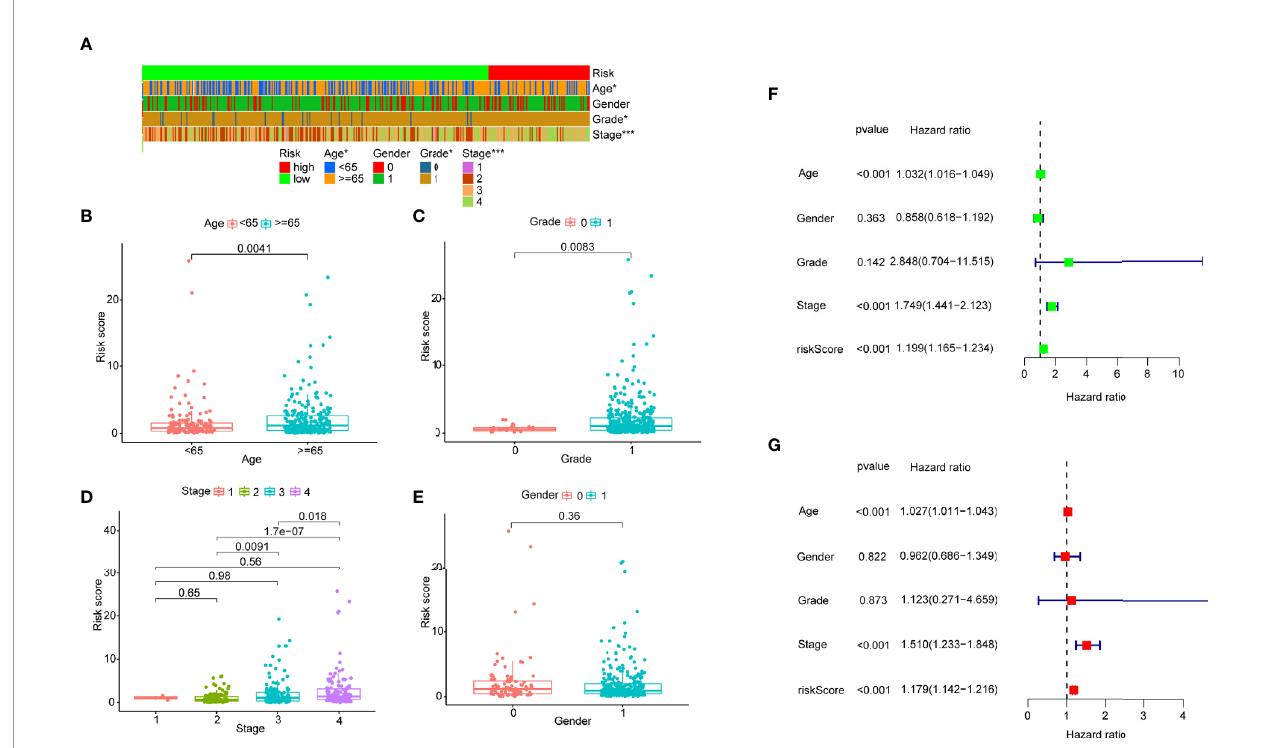
FIGURE 5 | (A) A strip chart and the scatter diagram demonstrated that (B) age, (C) tumor grade, (D) T stage and (E) gender were apparently associated with the riskScore. 0 represent female, 1 represents male. (F) A univariate Cox hazard analyses showed that age (p < 0.001, HR = 1.032, 95% CI [1.016 – 1.049]), T stage (p < 0.001, HR = 1.749, 95% CI [1.441-2.123]), riskScore (p < 0.001, HR = 1.199, 95% CI [1.165-1.234]) were statistically different, and age (p < 0.001, HR = 1.027, 95% CI [1.011 – 1.043]), T stage (p < 0.001, HR = 1.510, 95% CI [1.233-1.848]), riskScore (p < 0.001, HR = 1.179, 95% CI [1.142-1.216]) were statistically different in multivariate Cox hazard analyses (G)